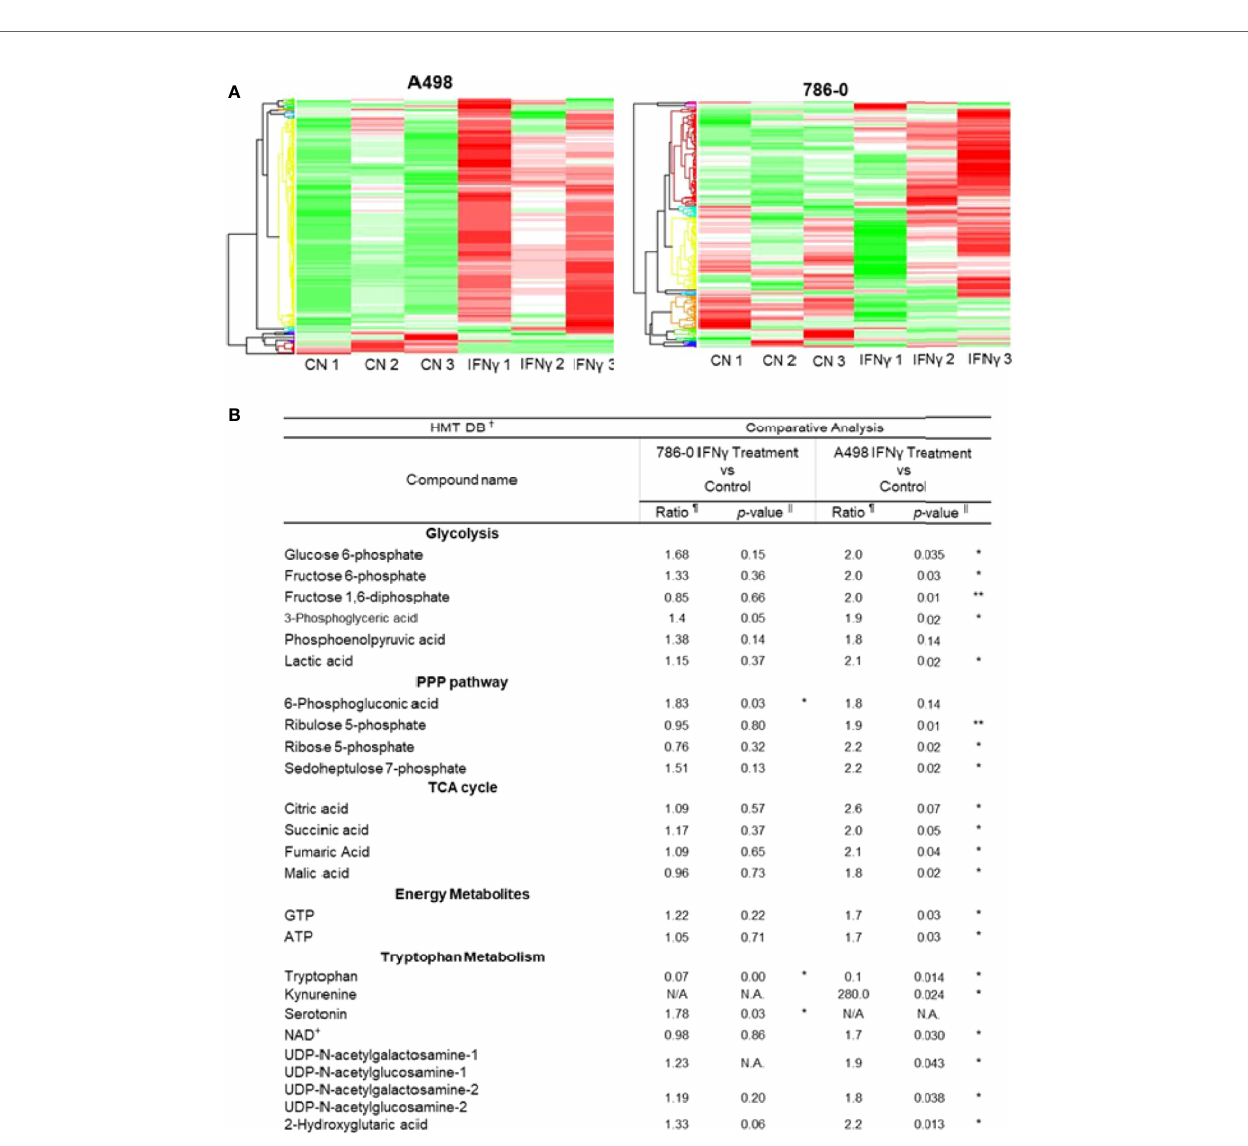
FIGURE 2 | IFN g treatment promotes aerobic glycolysis and tryptophane metabolism in A498 and 786-O. (A) The heat maps indicate a distinct metabolic rewiring following IFN g treatment in A498 and 786-O cells as compared to controls. n=3 for each group. (B) Comparative analysis of metabolites of glycolysis, PPP (pentose phosphate pathway), TCA cycle (tricarboxylic acid), and energy metabolites between IFN g treated and control A498 and 786-O cells. Putative metabolites which were assigned on the basis of m/z and MT in HMT standard compound library. The ratio is computed by using averaged detection values. The latter was used as denominator. The p-value is computed by Welch ’ s t-test (*p<0.05, **p<0.001). N.A., not